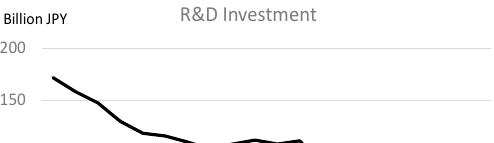
Figure 2. Trend of total sales.